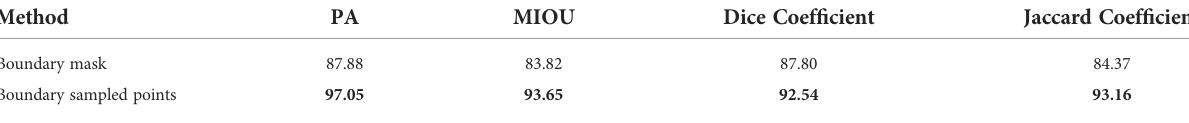
TABLE 4 Evaluation of using boundary mask and boundary-sampled points on prostate ultrasound images. Method